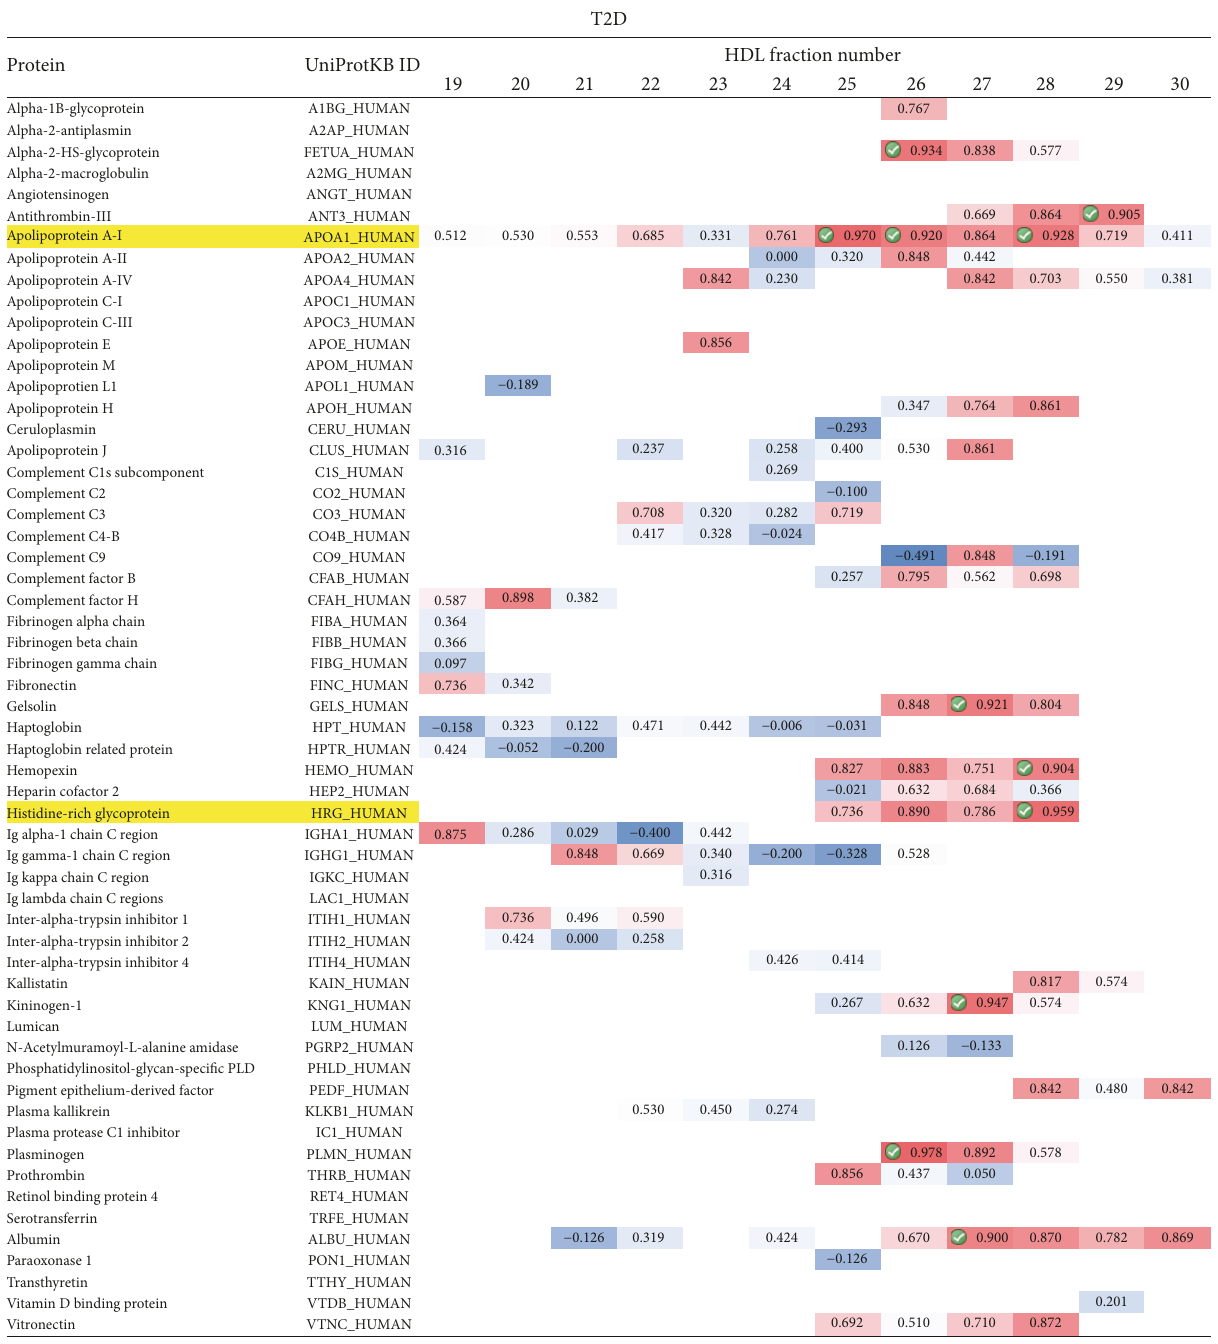
Figure 2: PCCs of peptide counts of individual proteins with PWV for the T2D group across HDL fractions. Red, white, and blue are used to mark maximal, medium, and minimum value, respectively. Green checkmark indicates significant correlation. The proteins that also correlate with PWV in the lean group are highlighted in